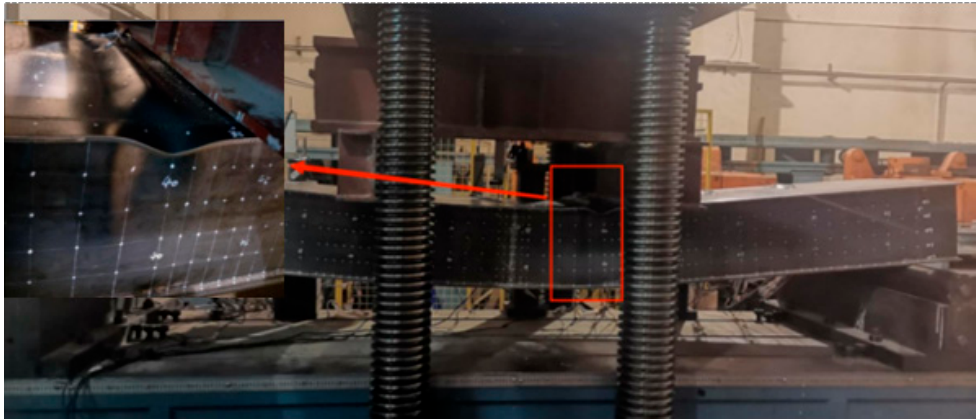
Figure 9. The final failure morphology of the specimen.